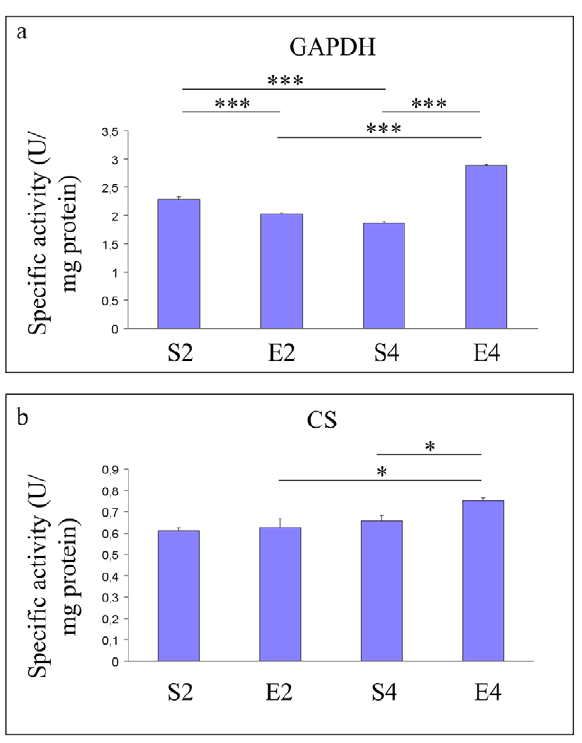
Figure 5. Energy-related enzymatic metabolism in hippocampi of mice undergoing 2- or 4-mo moderate treadmill running. Assessment of hippocampal specific activities of glyceraldehydes-3- phosphate dehydrogenase (GAPDH) and citrate synthase (CS) in mature CD-1 female mice undergoing a two- or four-month moderate and regular treadmill-based exercise program (E2 or E4, respectively); age- matched sedentary animals (S2, S4) were used as controls (n=12 per group). An age-dependent decrease in GAPDH specific activity (S4 vs S2) (panel a) was detected, whereas no significant age-related changes in CS activity were observed (S4 vs S2) (panel b). 2-mo running reduced the GAPDH specific activity (E2 vs S2) (panel a), yet 2-mo exercise did not alter the CS activity (E2 vs S2) (panel b). 4-mo running increased activities of both GAPDH and CS (E4 vs S4) (panels a and b, respectively). Values were given as means 6 std. dev. The level of statistical significance was computed by using two-way ANOVA and post-hoc Newman-Keuls test: *** P , 0.001; * P , 0.05. Experiments were performed in triplicate.